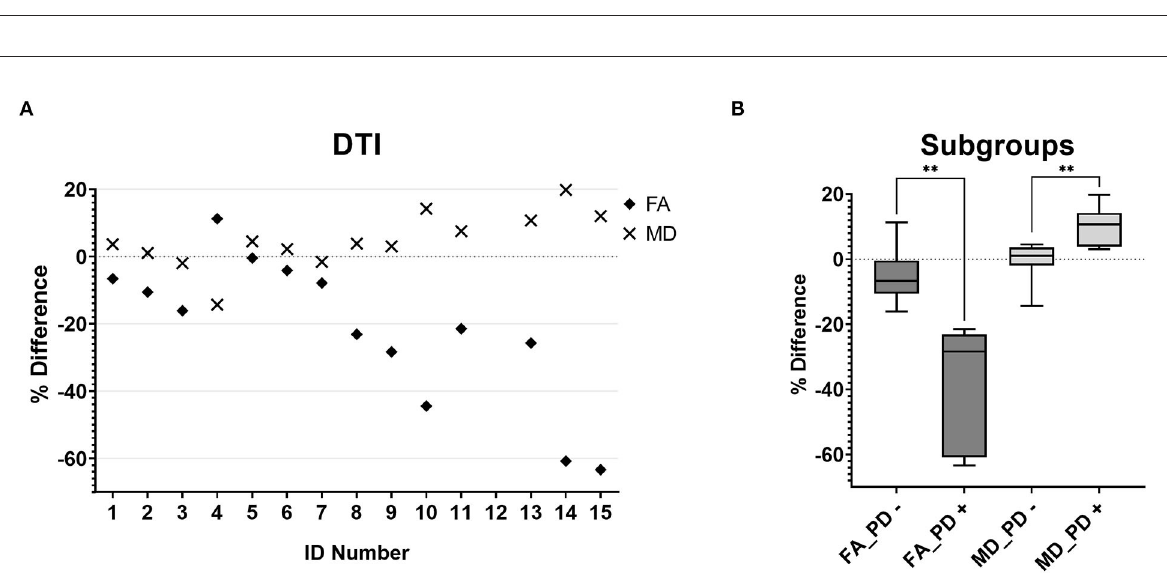
FIGURE2 distribution of disease controls is to be expected. Accordingly, values above the threshold are deemed indicative of HOD in the patient cohort. It is noted that patient number 2 has a false-positive finding in T2-w (B) due to T2 hypointensities in the left anterior medulla oblongata. PD, proton-density; FLAIR, fluid-attenuated inversion recovery; HOD, hypertrophic olivary degeneration.